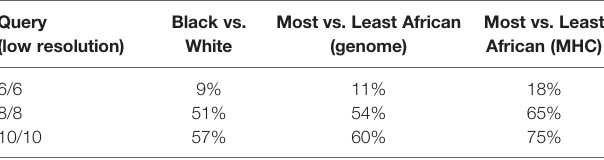
TABLE 3 | Percent decrease in the chances of fi nding at least one match for “ Black ” or most genetically African individuals, relative to “ White ” or least genetically Africans,